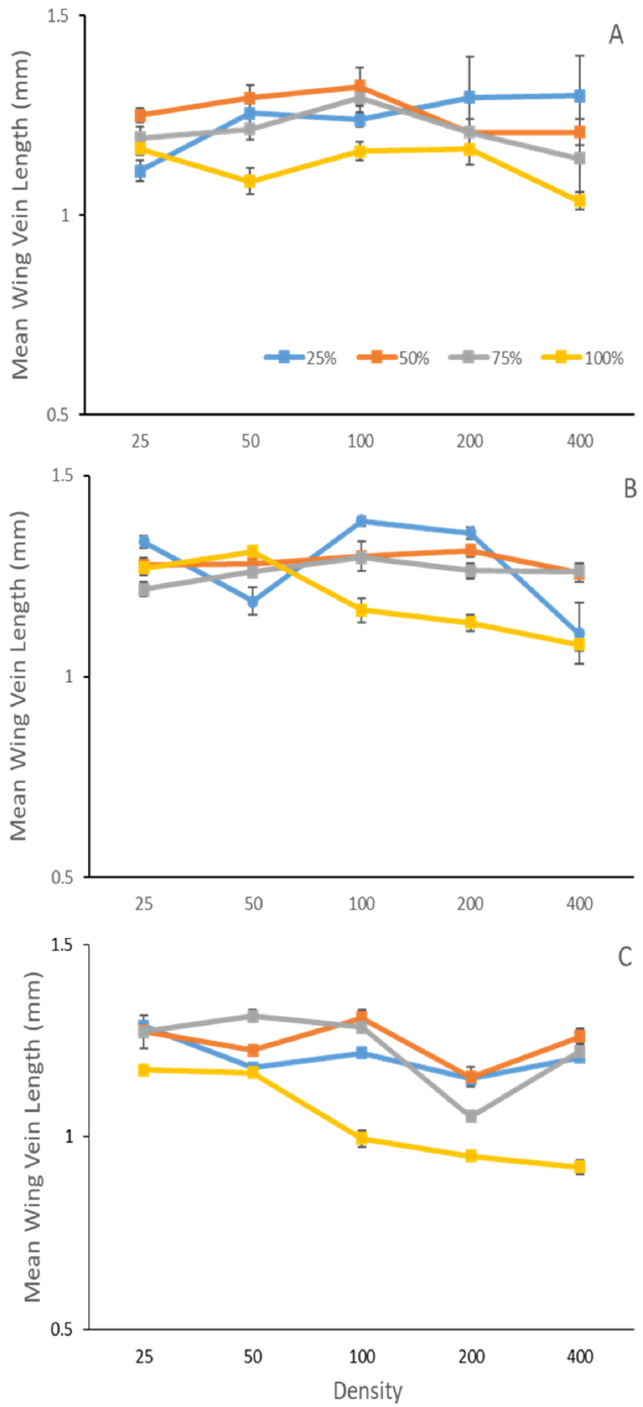
Figure 1. Mean ± SE adult body size of Phormia regina Meigen (Diptera: Calliphoridae) (as measured by the length of the posterior cross-vein to dm-cu vein of the left wing) reared within larval ratios of 100% P. regina , 75% P. regina to 25% Lucilia sericata Meigen (Diptera: Calliphoridae), equal 50:50 ratio, or 25% P. regina to 75% L. sericata at ( A ) 15 ◦ C, ( B ) 25 ◦ C, and ( C ) 35 ◦ C across densities (larvae/jar). There was an interaction between density, species treatment, and temperature (F 3,997 = 3.9 p = 0.008) between 15 ◦ C and 25 ◦ C, such that at 15 ◦ C P. regina body size was smaller than other species ratios at low density and larger than other species ratios at high density. The opposite trend occurred at 25 ◦ C, with a decrease in body size with an increase in density, compared to the other heterospecific species ratios (Figure